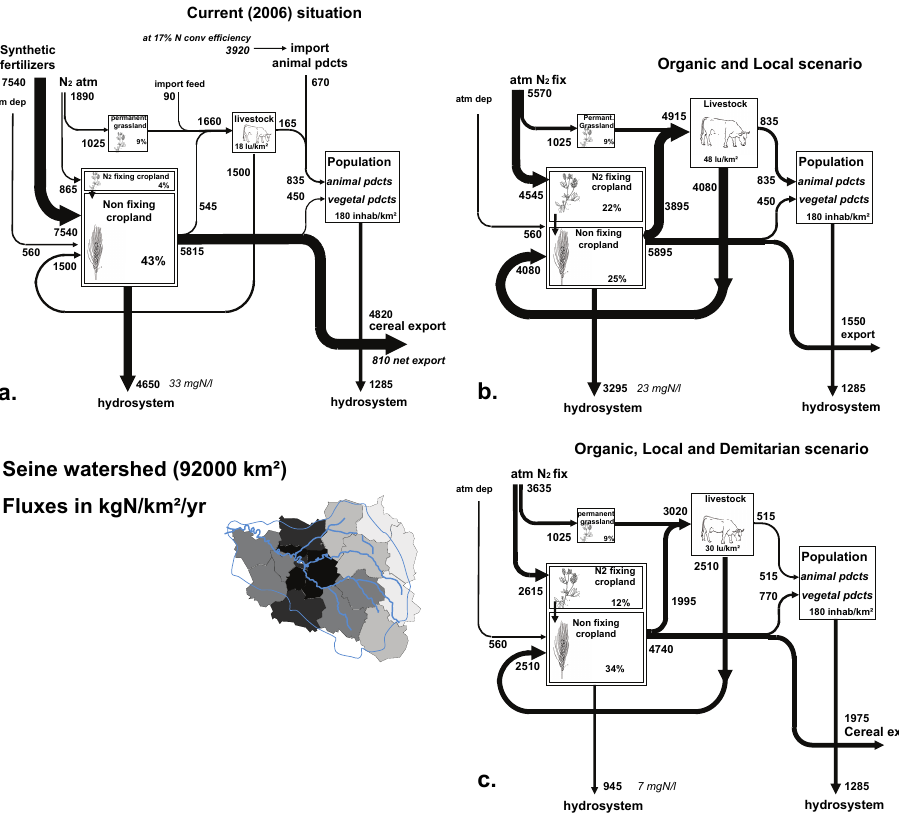
Fig. 3. Nitrogen fluxes in the agricultural system of the Seine watershed (fluxes expressed in kgN per km 2 of watershed area and per year). (a) Current situation (2006). (b) Organic and local scenario (OrgLoc). (c) Organic, local and demitarian scenario (OrgLocDem).